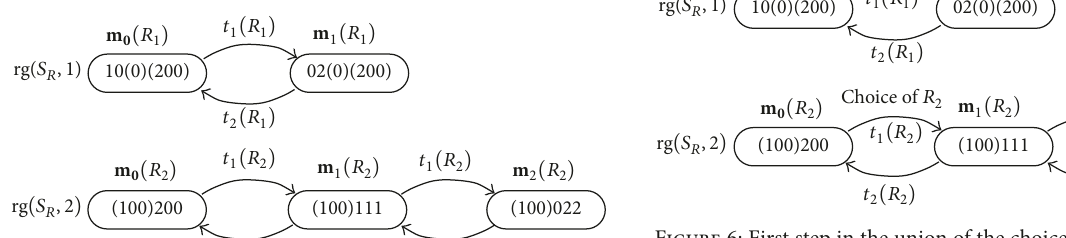
Figure 6: First step in the union of the choice subgraphs of 𝑅 1 and 𝑅 2 , alternative Petri nets.